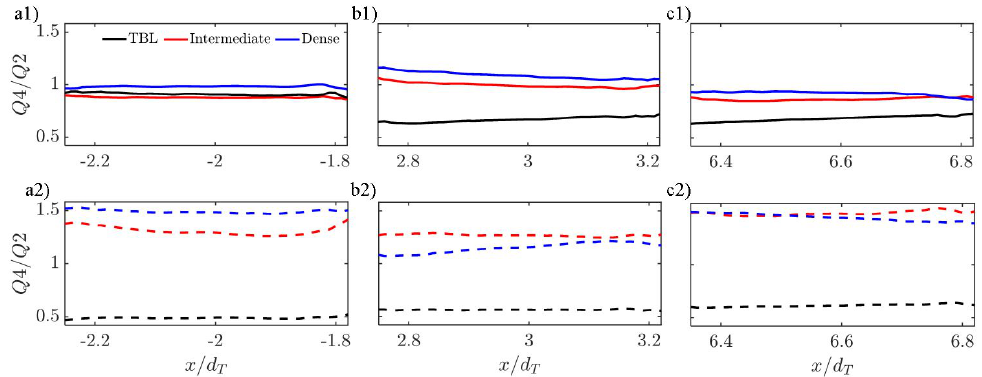
Figure 9. Ratio of total contribution of sweep ( Q 4) and ejection ( Q 2) events in the ( a ) incoming flow, ( b ) x / d T = 3, and ( c ) x / d T = 6.5 at ∆ z / z h ub = 0.11 (solid lines) above the surface and z / z hub = 1.6 (dashed